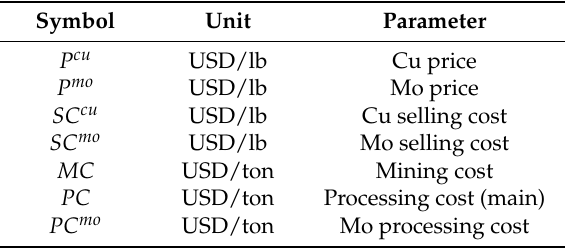
Table 1. Summary of economic parameters for block valuation.